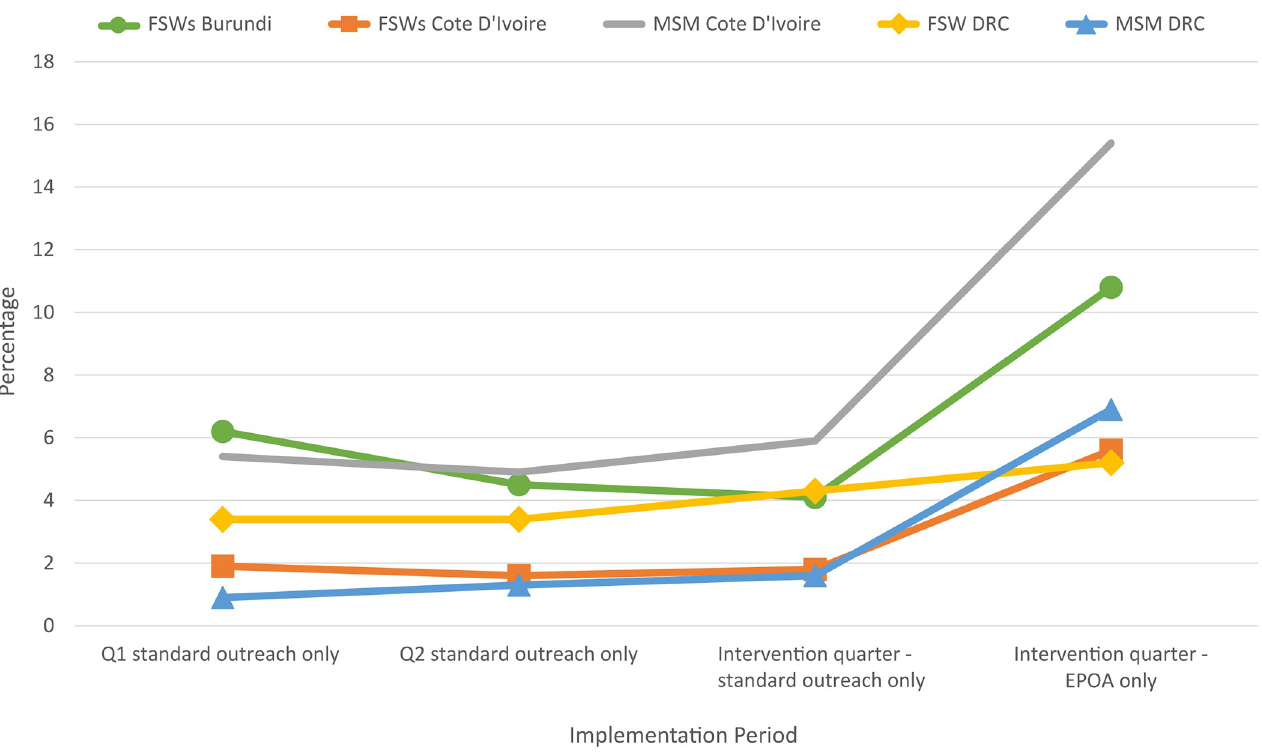
Fig 2. Trends in HIV seropositivity with standard outreach compared with the EPOA for FSWs and MSM in Burundi, Cote d’Ivoire, and DRC, 2017.